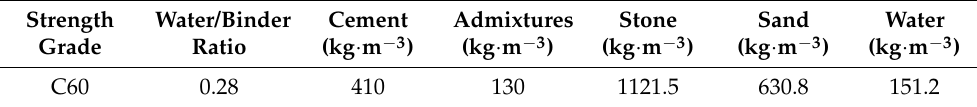
Table 6. The reference mix ratio of the C60 high-strength